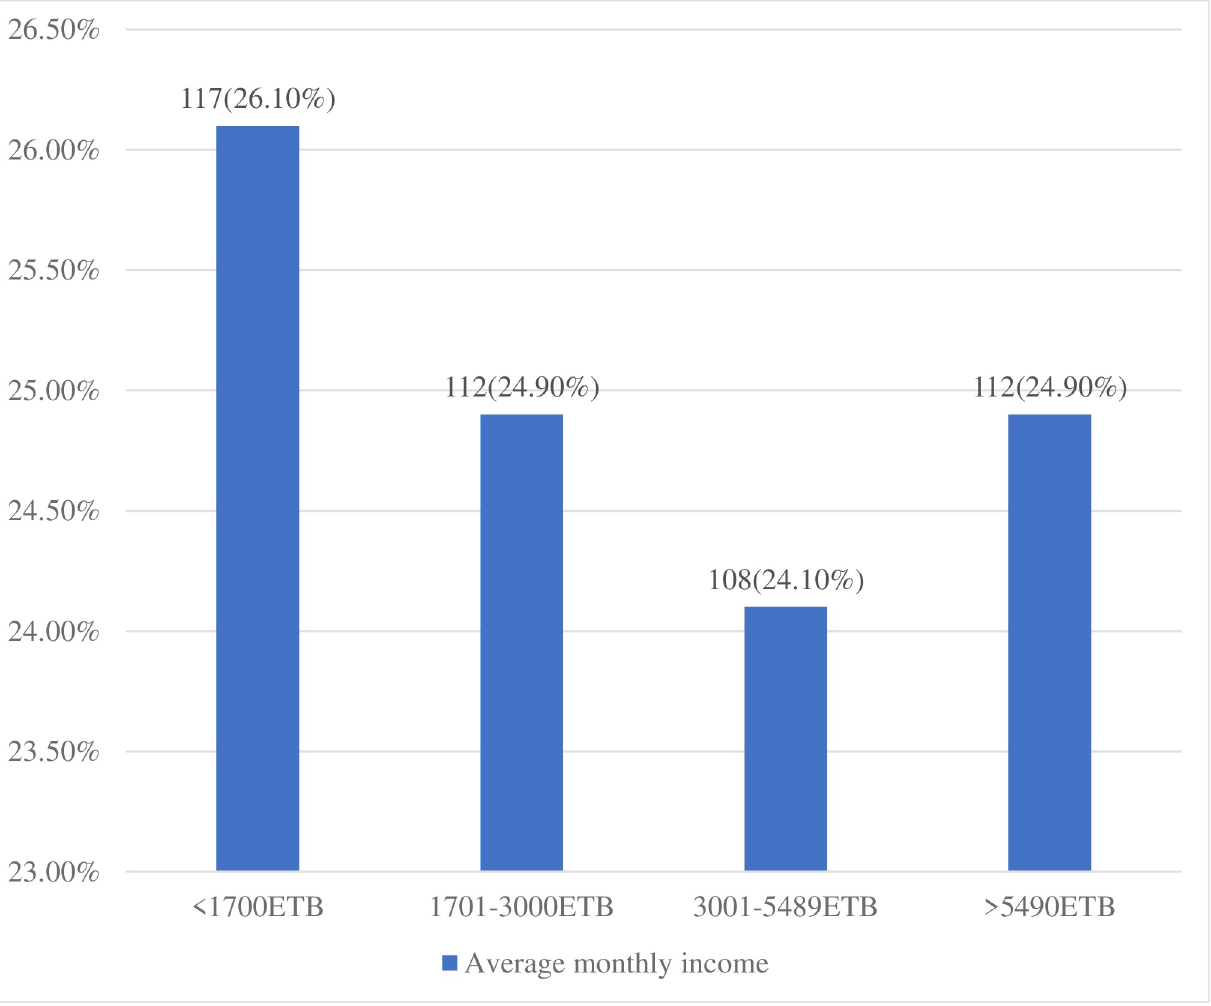
Fig 2. Average monthly income of adult cancer patients receiving cancer treatment at oncology unit in Amhara region, Ethiopia, 2022 (N = 449).